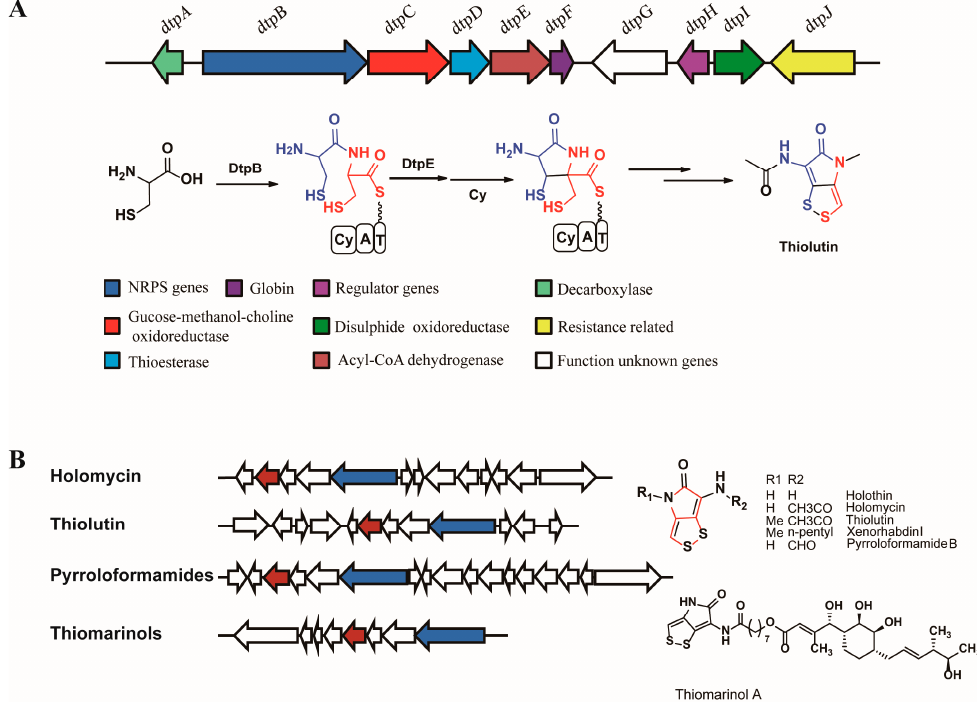
Figure 1. Biosynthetic gene clusters and putative pathway of dithiolopyrrolones. ( A ) Putative biosynthetic pathway of thiolutin. ( B ) Biosynthetic gene clusters of reported dithiolopyrrolones. The genes coding for acyl-CoA dehydrogenase are in red and the genes coding for NRPS are in blue.